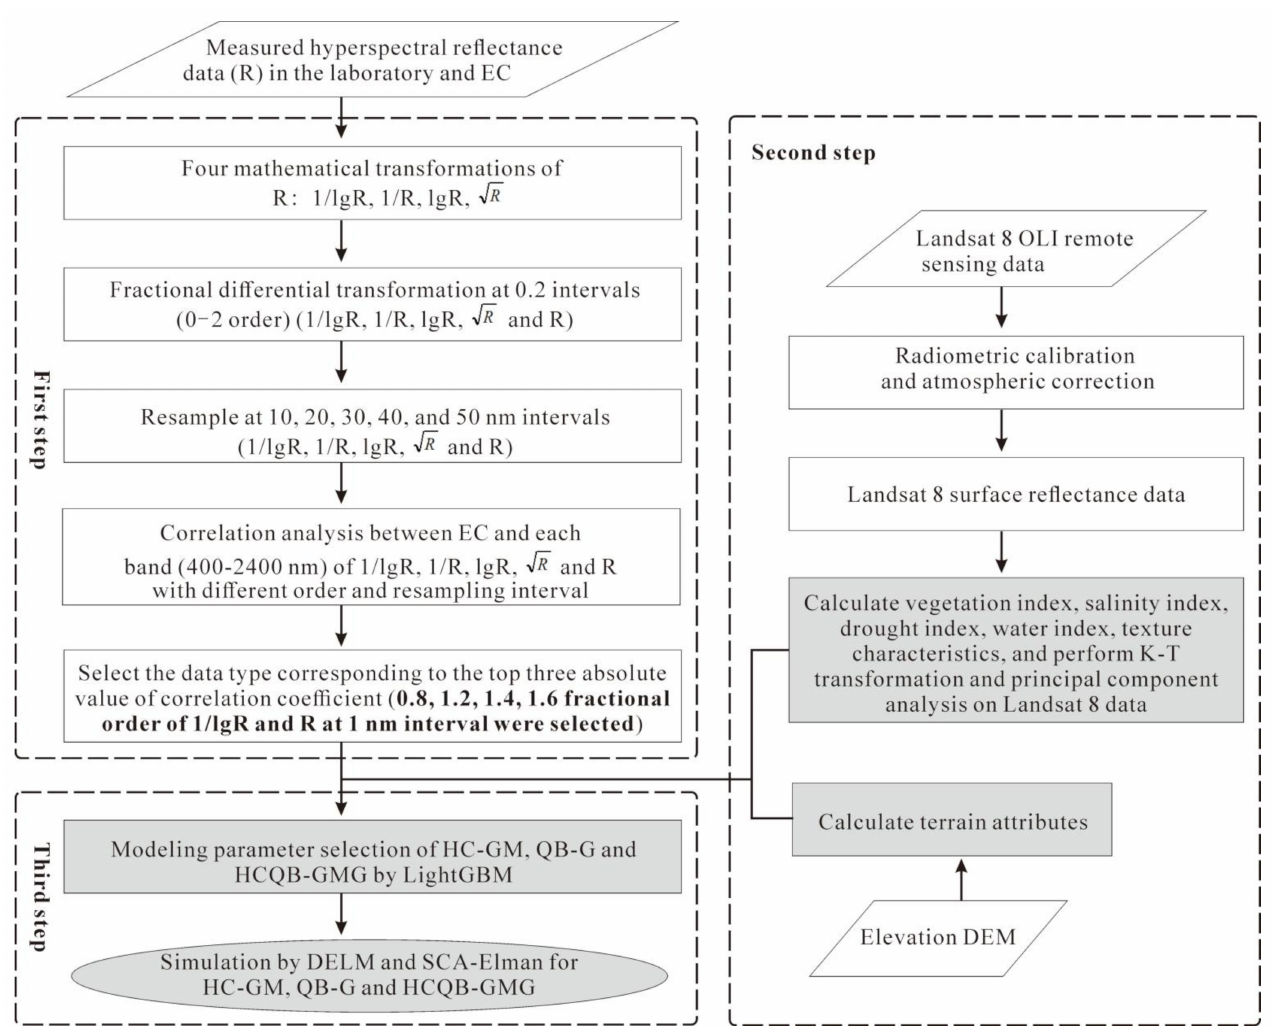
Figure 2. Technical flowchart of this